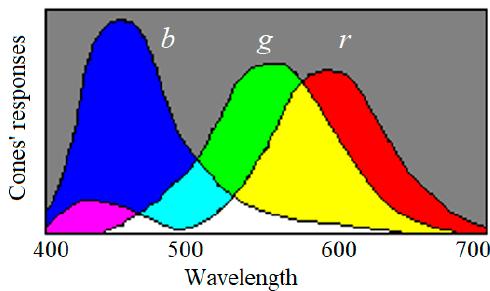
Figure A1. Illustrating the fuzzy logic in the decoding model.